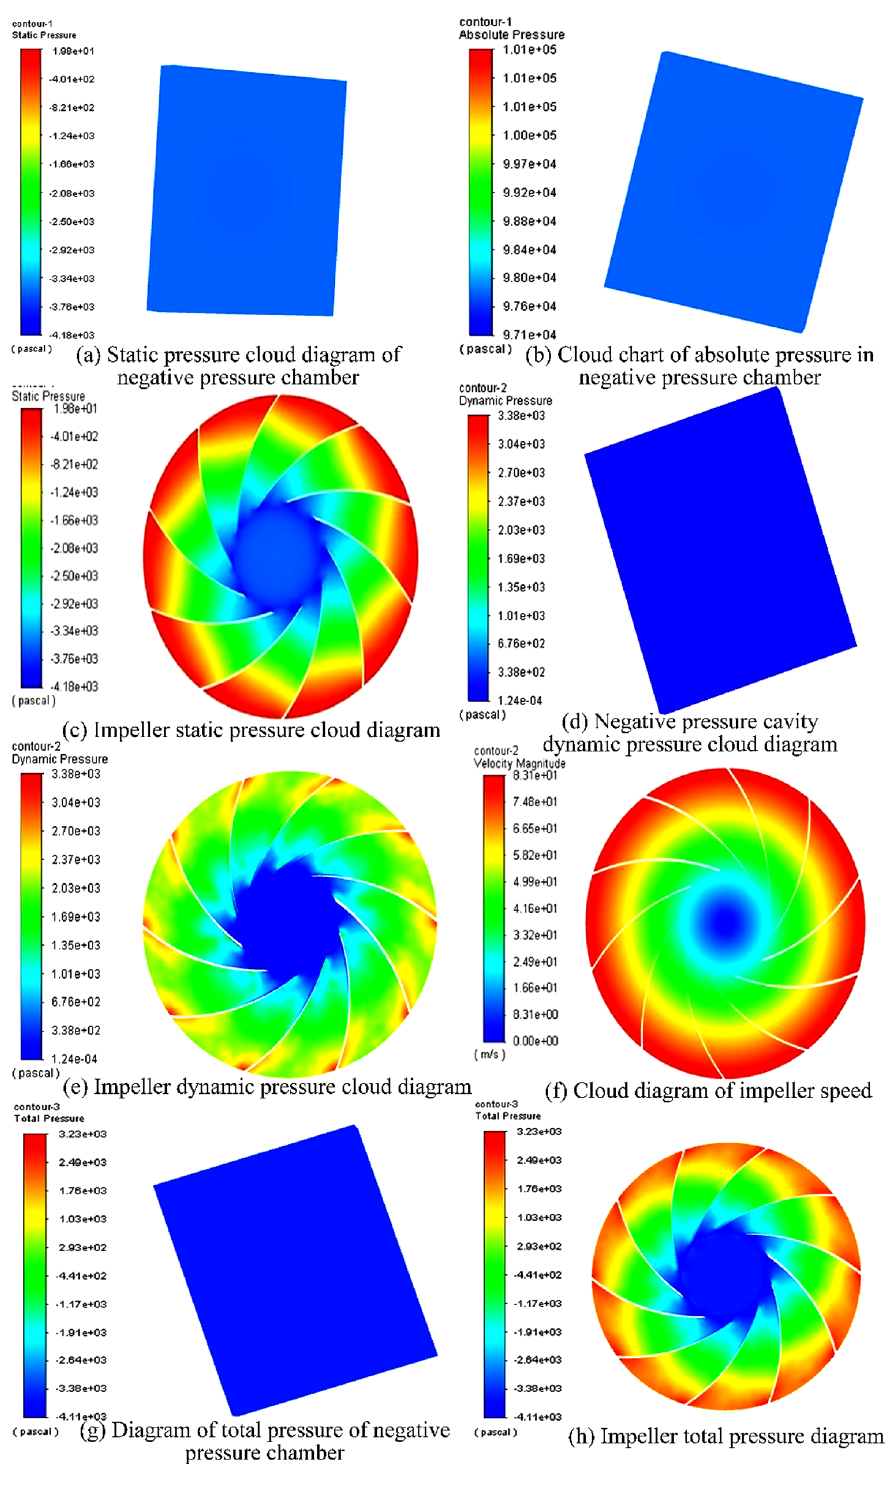
Figure 13. Pressure cloud diagram of impeller and negative pressure